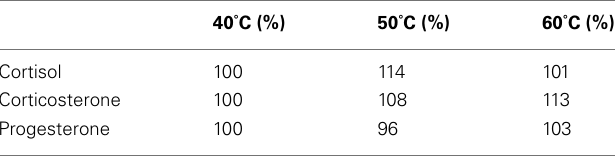
Table 1 | Effect of drying temperature on measured steroid